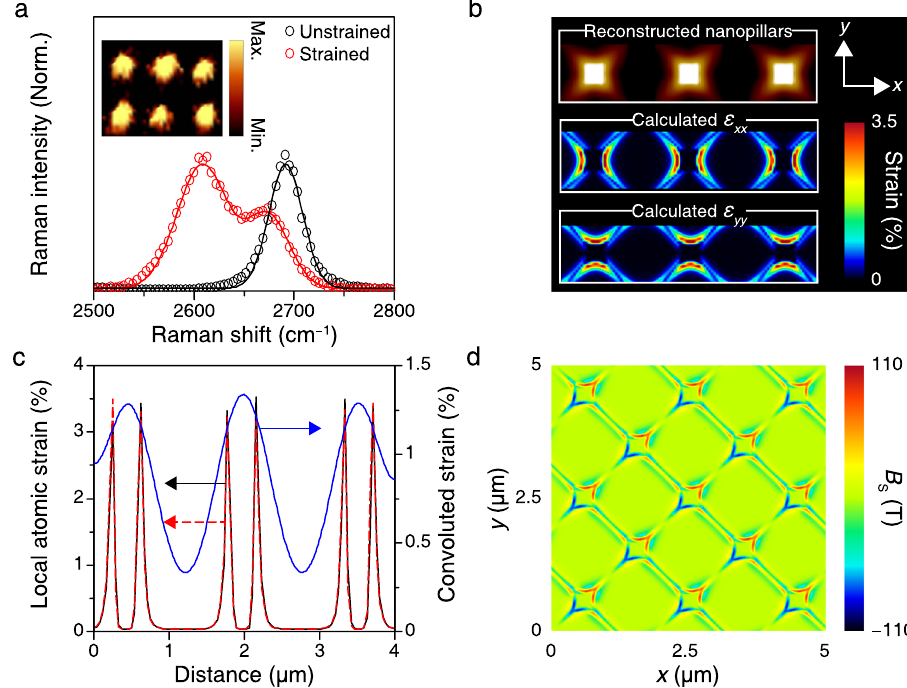
Fig. 2 Formation of strong pseudo-magnetic fi elds in highly strained graphene. a Raman spectra of unstrained (black) and strained (red) graphene. Symbols are measurement data; curves are fi tting data. Inset: Two-dimensional Raman mapping data plotting the 2D peak frequency of a 3 × 2 strained graphene nanopillar array. b The topographic image of the reconstructed a 3 × 1 strained graphene nanopillar array (top panel) and corresponding local strain distributions along the x ( ϵ xx , middle panel) and y ( ϵ yy , bottom panel) directions. The brightest and darkest regions in the topographic image indicate 300-nm and 0-nm heights of structure, respectively. c Cross-section of the strain pro fi le showing local atomic strain for ϵ xx (black solid line) and ϵ yy (red dashed line), and convoluted strain distribution (blue solid line). d Pseudo-magnetic fi elds distribution in strained graphene nanopillar